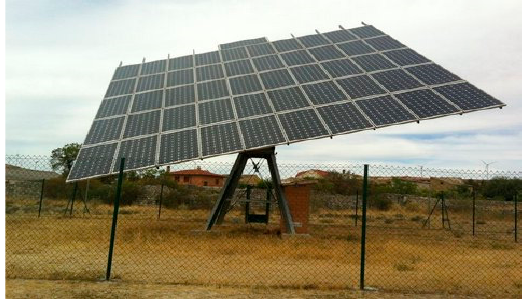
Figure 4. System 3 facility located at Los Balbases (Burgos). Two-axis sun tracker